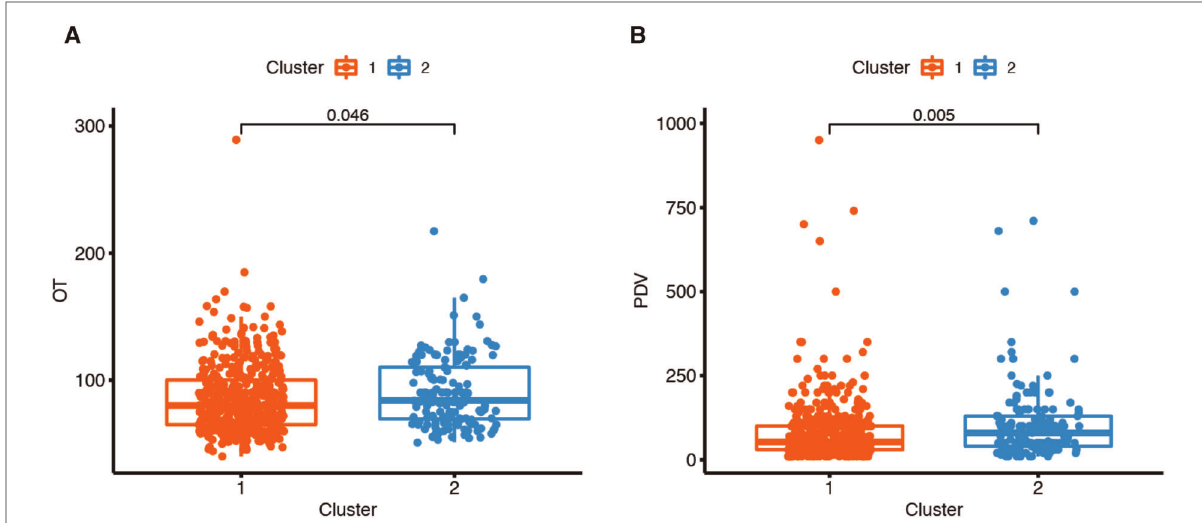
FIGURE 5 Two clustered boxplots of operative time and postoperative drainage volume. ( A ) The operation time (OT) of cluster 1 was 80[65, 100] min, and that of cluster 2 was 84[69, 110] min. The operation time of cluster 1 was signi fi cantly shorter than that of cluster 2 ( p =0.046). ( B ) The postoperative drainage volume (PDV) of cluster 1 was 53[30, 100] ml, and that of cluster 2 was 80[40, 130] ml. The postoperative drainage volume of cluster 1 was signi fi cantly less than that of cluster 2 ( p =0.005).